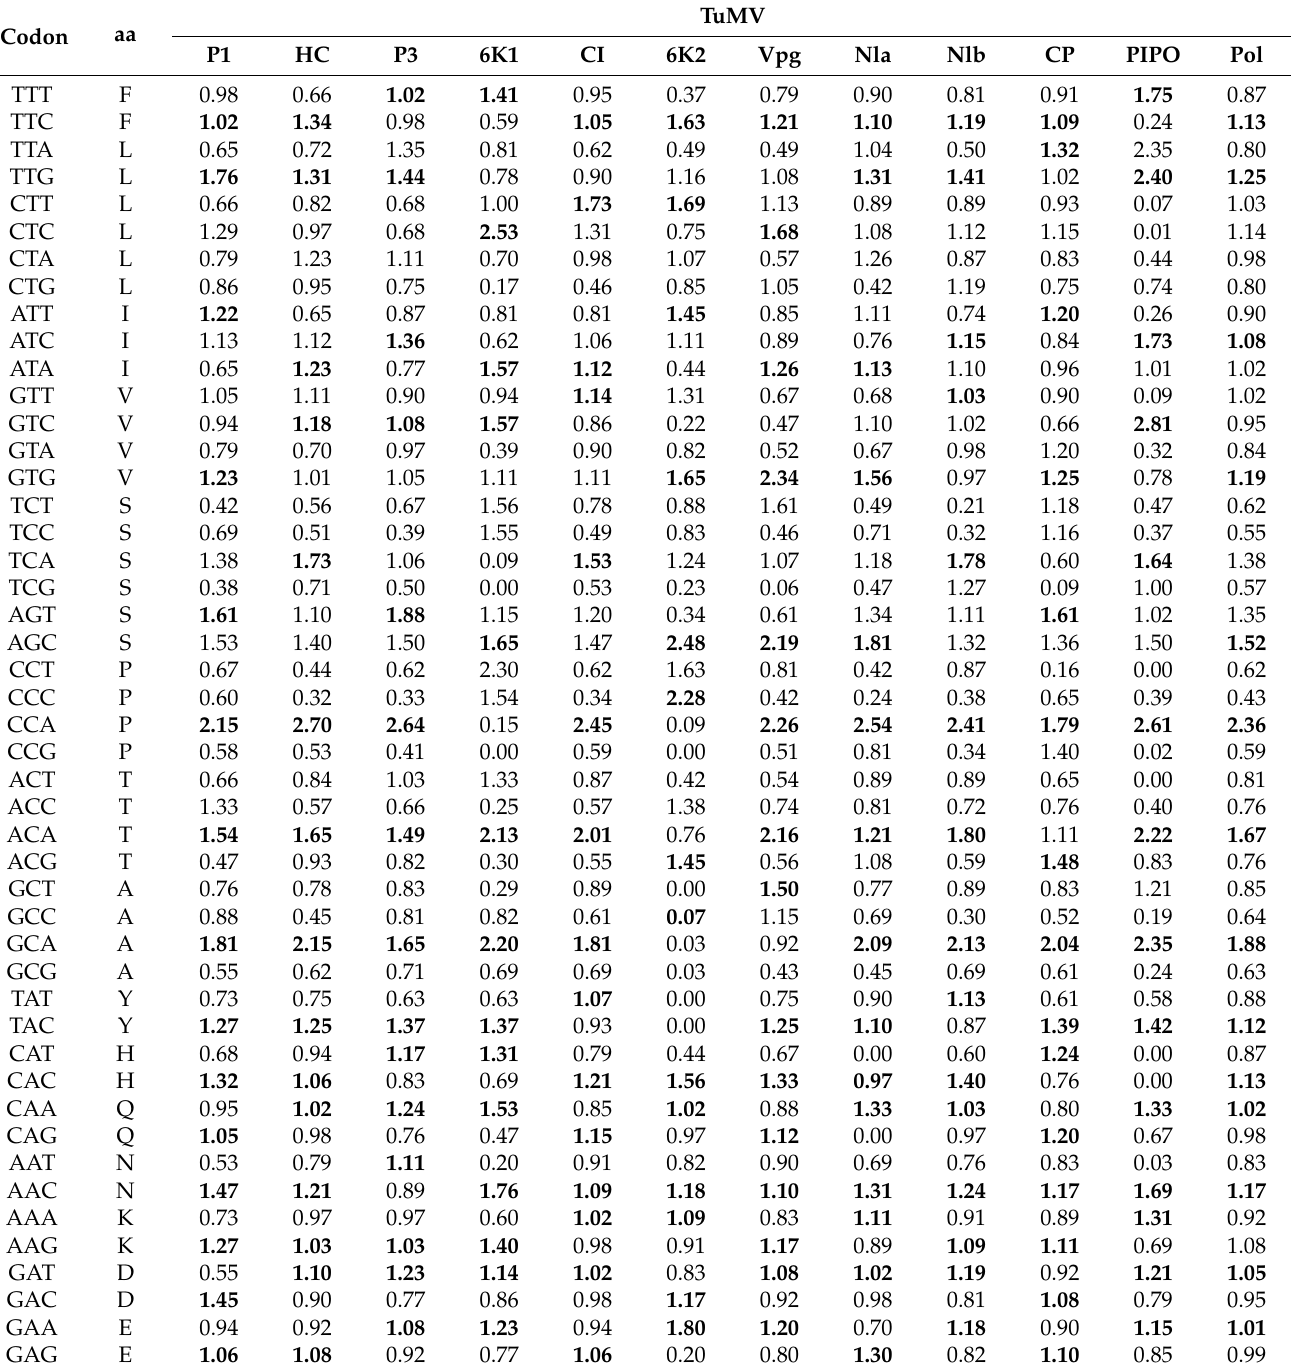
Table 1. The relative synonymous codon usage (RSCU) value of 59 codons encoding 18 amino acids according to 11 protein and polyprotein of turnip mosaic